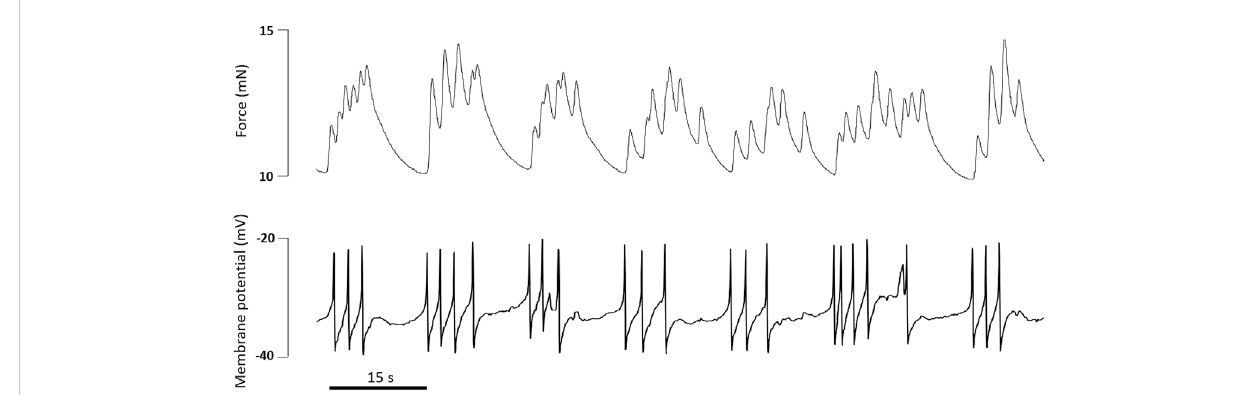
FIGURE 9 Original traces of force and membrane potential simultaneously recorded in an experiment on rat tail artery. Incubation with the α 1 -adrenoceptor agonist methoxamine (0.4 µM) and the BK Ca channel blocker Iberiotoxin (0.1 µM) caused the development of action potential-like spikes accompanied by phasic oscillations of